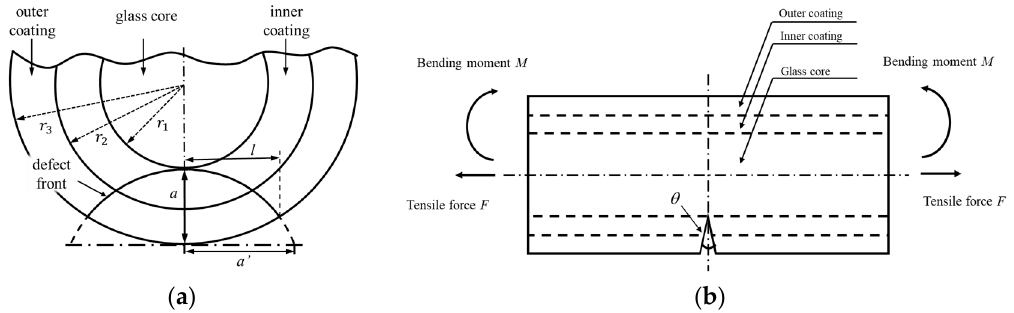
Figure 3. Crack defect position and optical fiber structure; ( a ) crack position and geometry on the optical fiber surface; ( b ) crack position and the external load.